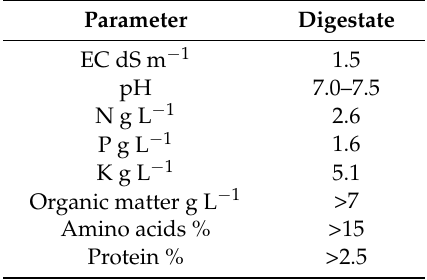
Table 3. Digestate